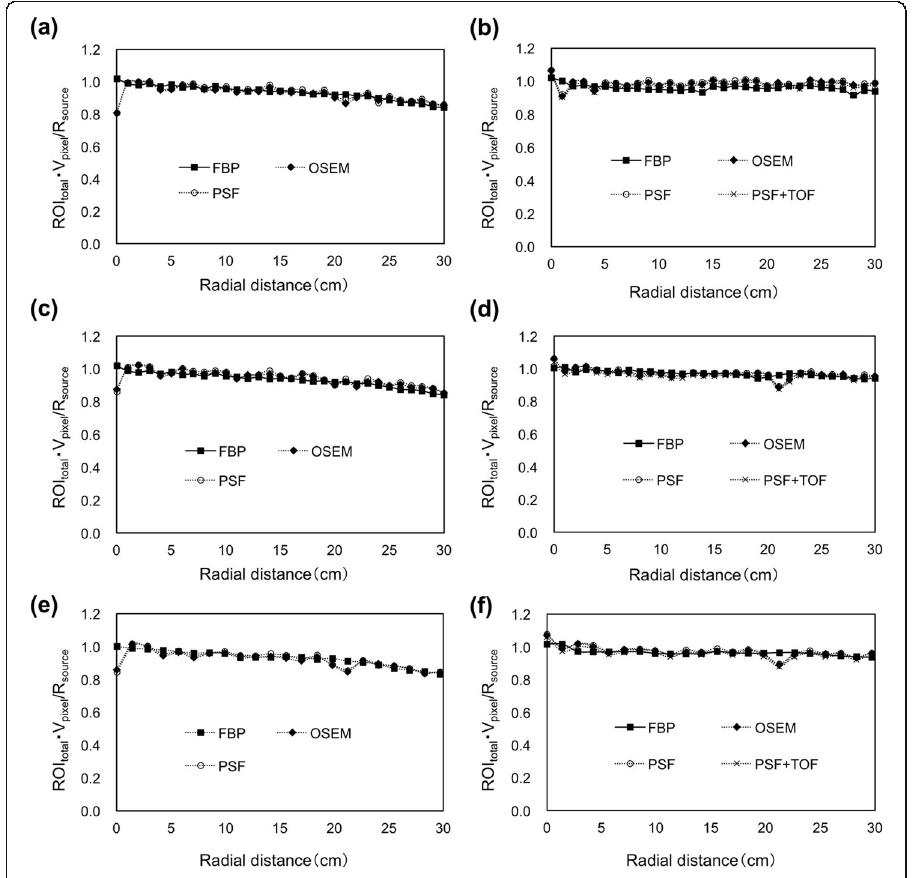
Discovery 600 ( a , c , e ) and Discovery 710 ( b , d , f